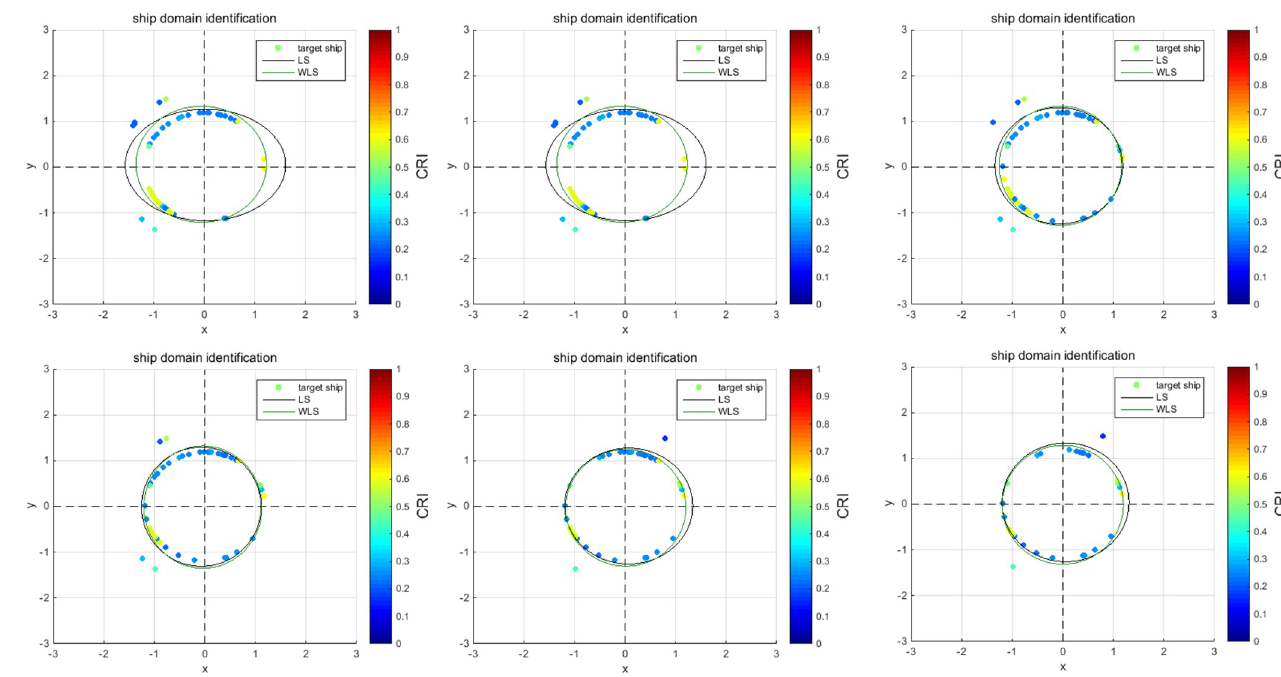
Fig 13. Online rolling identification results of the ship domain. (T1) Identification results at Time T1, correspondingly, � CRI � ¼ 0 : 38 ; (T2) Identification results at time T2, correspondingly, � CRI � ¼ 0 : 37 ; (T3) Identification results at time T3, correspondingly, � CRI � ¼ 0 : 38 ; (T4) Identification results at time T4, correspondingly, � CRI � ¼ 0 : 38 ; (T5) Identification results at Time T5, correspondingly, � CRI � ¼ 0 : 39 ; (T6) Identification results at Time T6, correspondingly, � CRI � ¼ 0 : 36 .